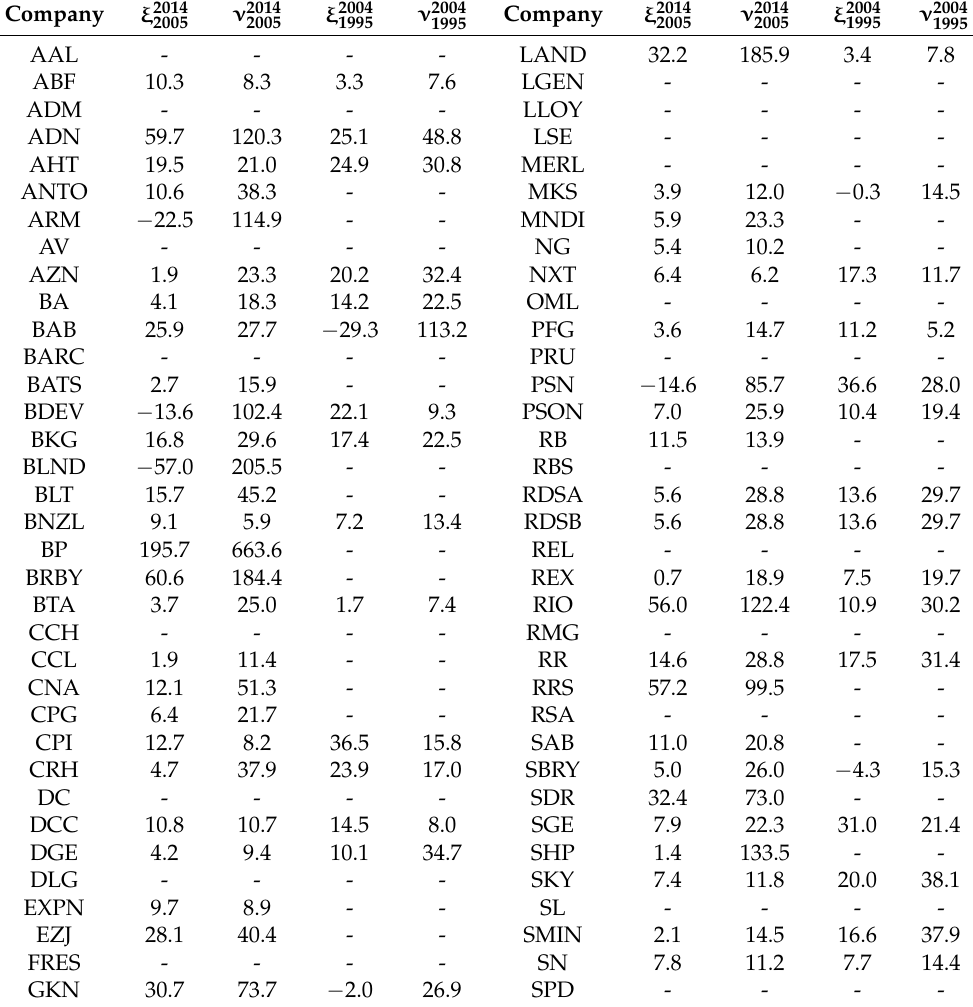
Table A2. Estimated parameters ξ ( % ) and ν ( % ) , for each company of UKX index.